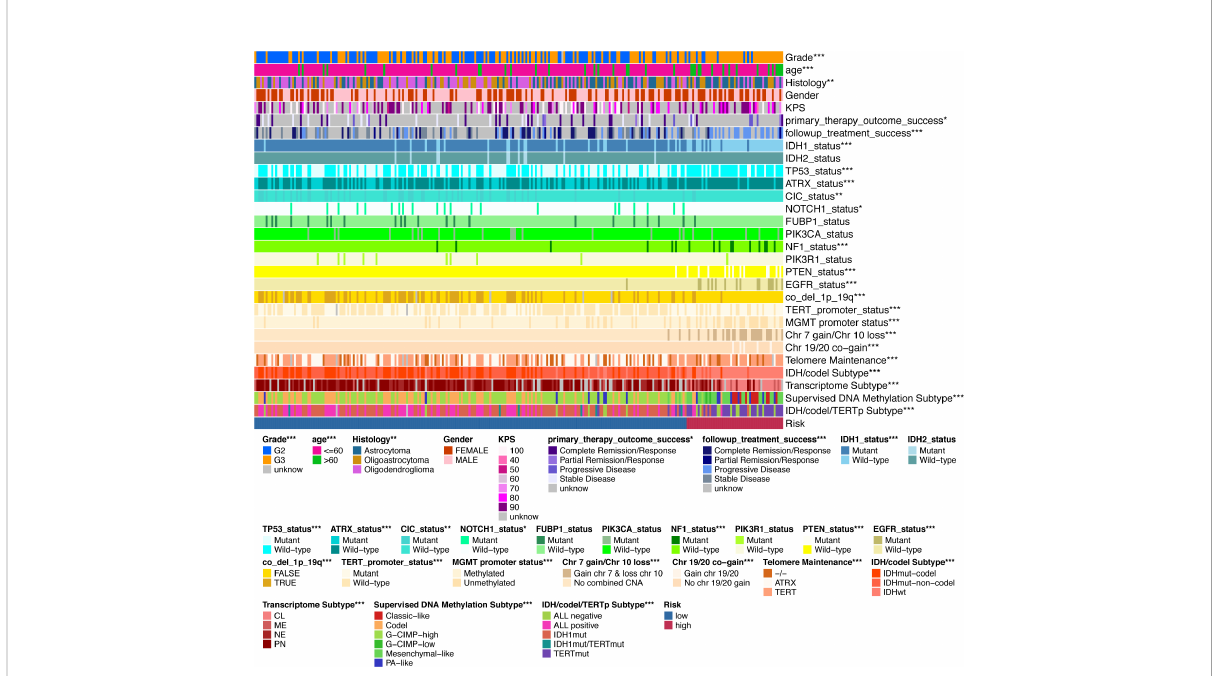
FIGURE 5 Validation of the clinical value of the IGFBPScore. Correlation heatmap of the IGFBPScore versus common clinical traits, therapeutic response, and molecular subtypes in the TCGA glioma cohort. For all experiments, *p<0.05, **p<0.01,